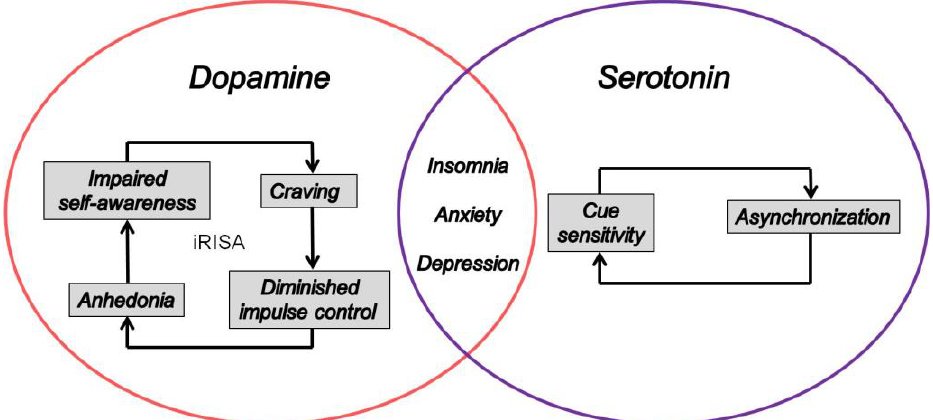
Figure 1. The iRISA syndrome [76] in addiction is centrally controlled by dopamine in the brain, while asynchronization, presumed to be linked to cue sensitivity in digital addiction [50–54], is centrally controlled by serotonin. A deficit in both neurotransmitters is identified as a brain correlate of insomnia, anxiety, and depression.